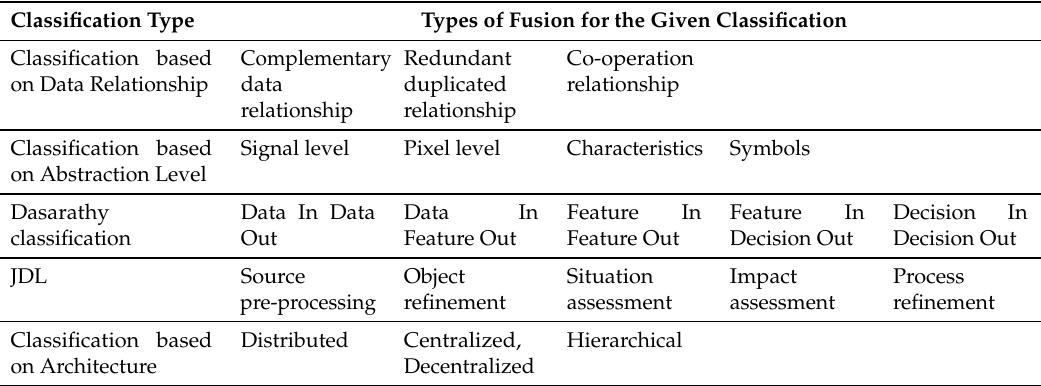
Table 1. Data fusion techniques and their